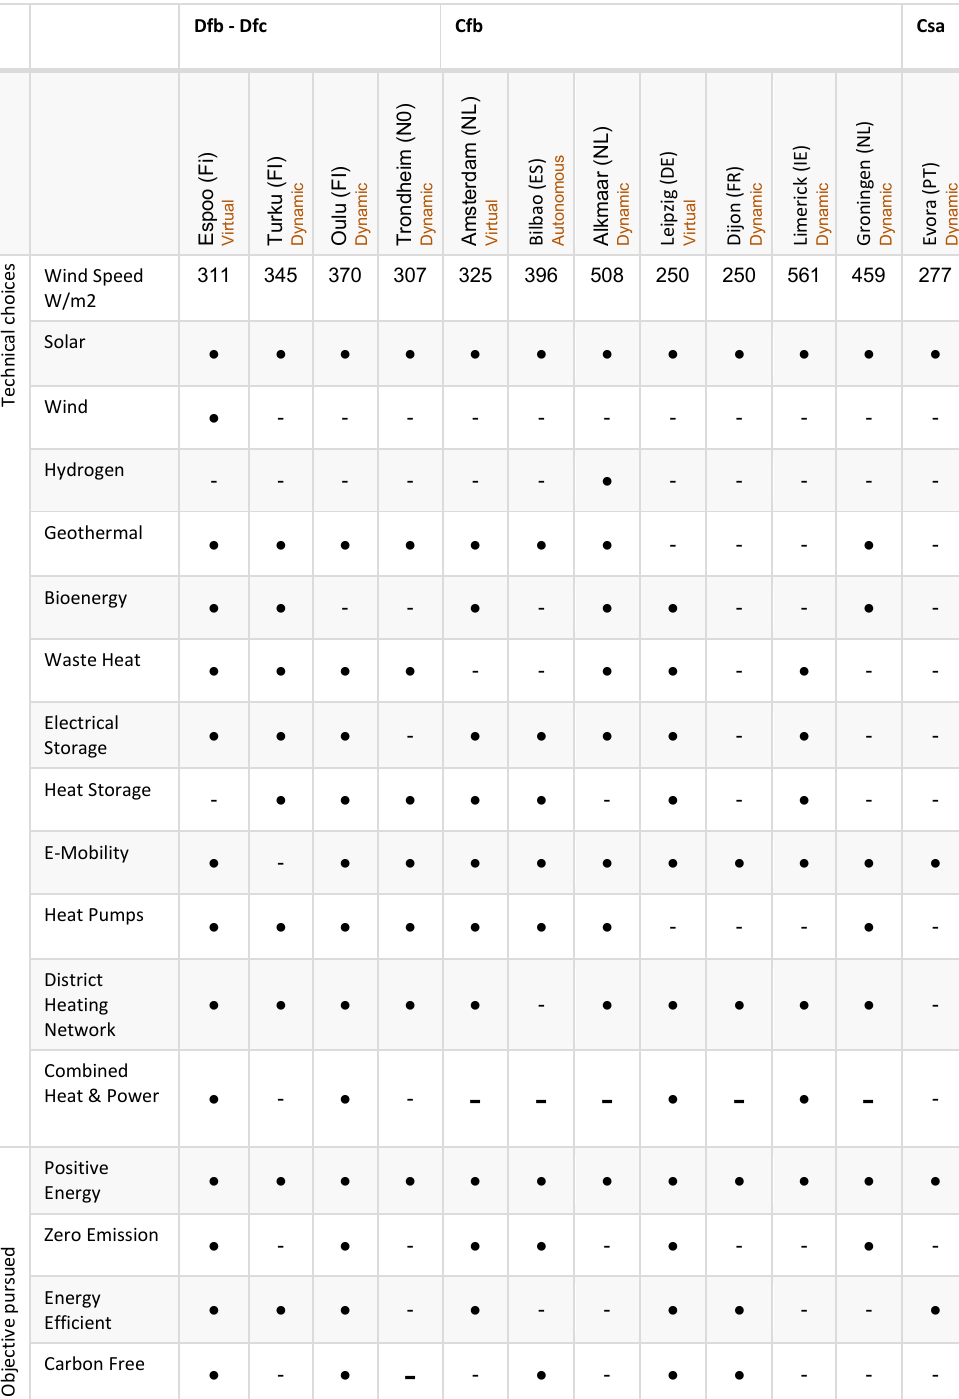
Figure 8. Data collection and systemisation of information of the analysed case studies. “ ● ” means that the technological solution was carried out, “-” means that the technology was not selected. Wind speed information was obtained with the Global Wind Atlas developed by the Technical Uni- versity of Denmark [111].